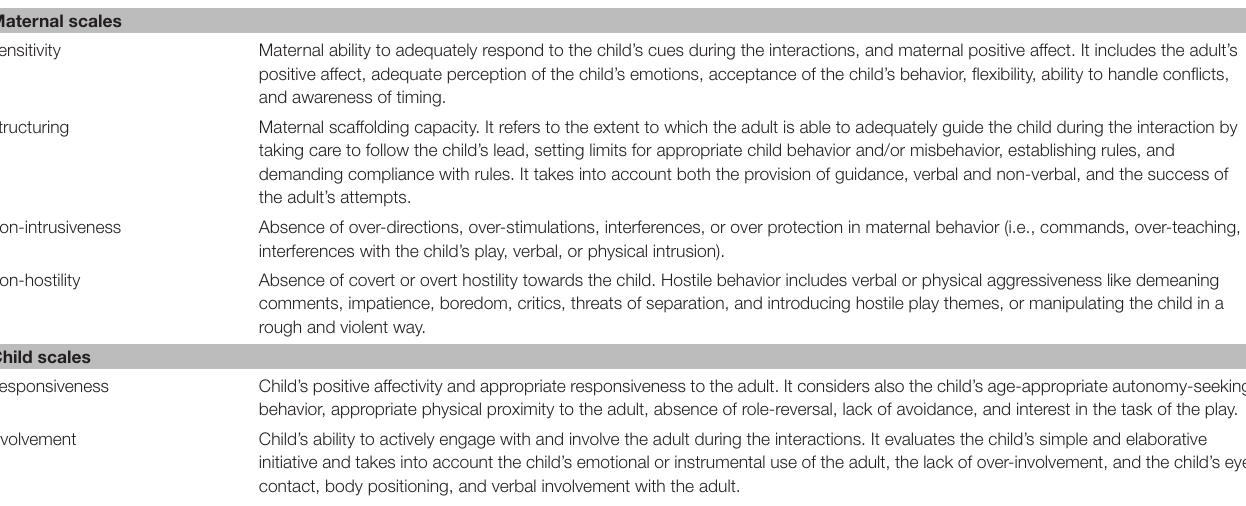
TABLE 1 | EAS Dimensions (adapted by Biringen, 2008). Maternal